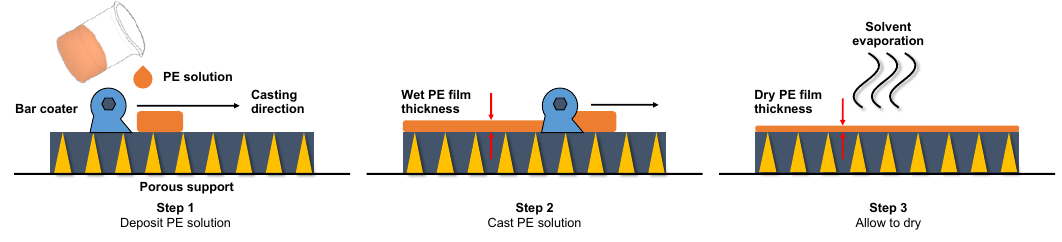
Figure 6. Physical layer deposition via solvent-casting